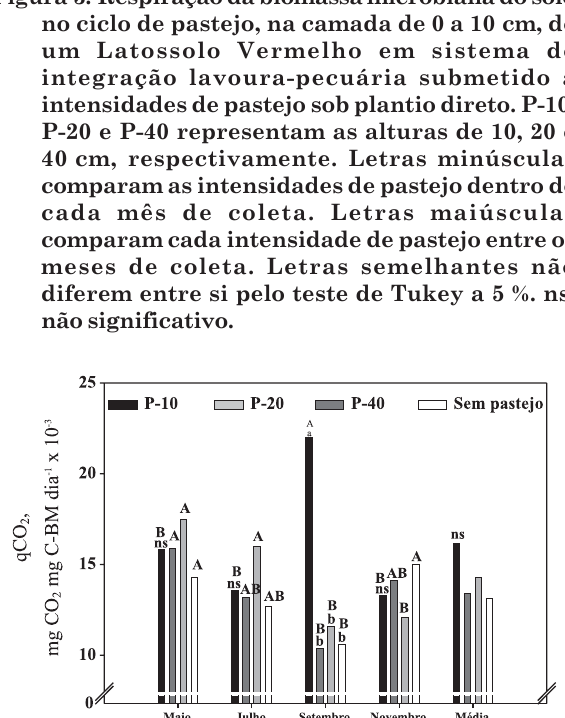
com isso, solos com baixo q CO